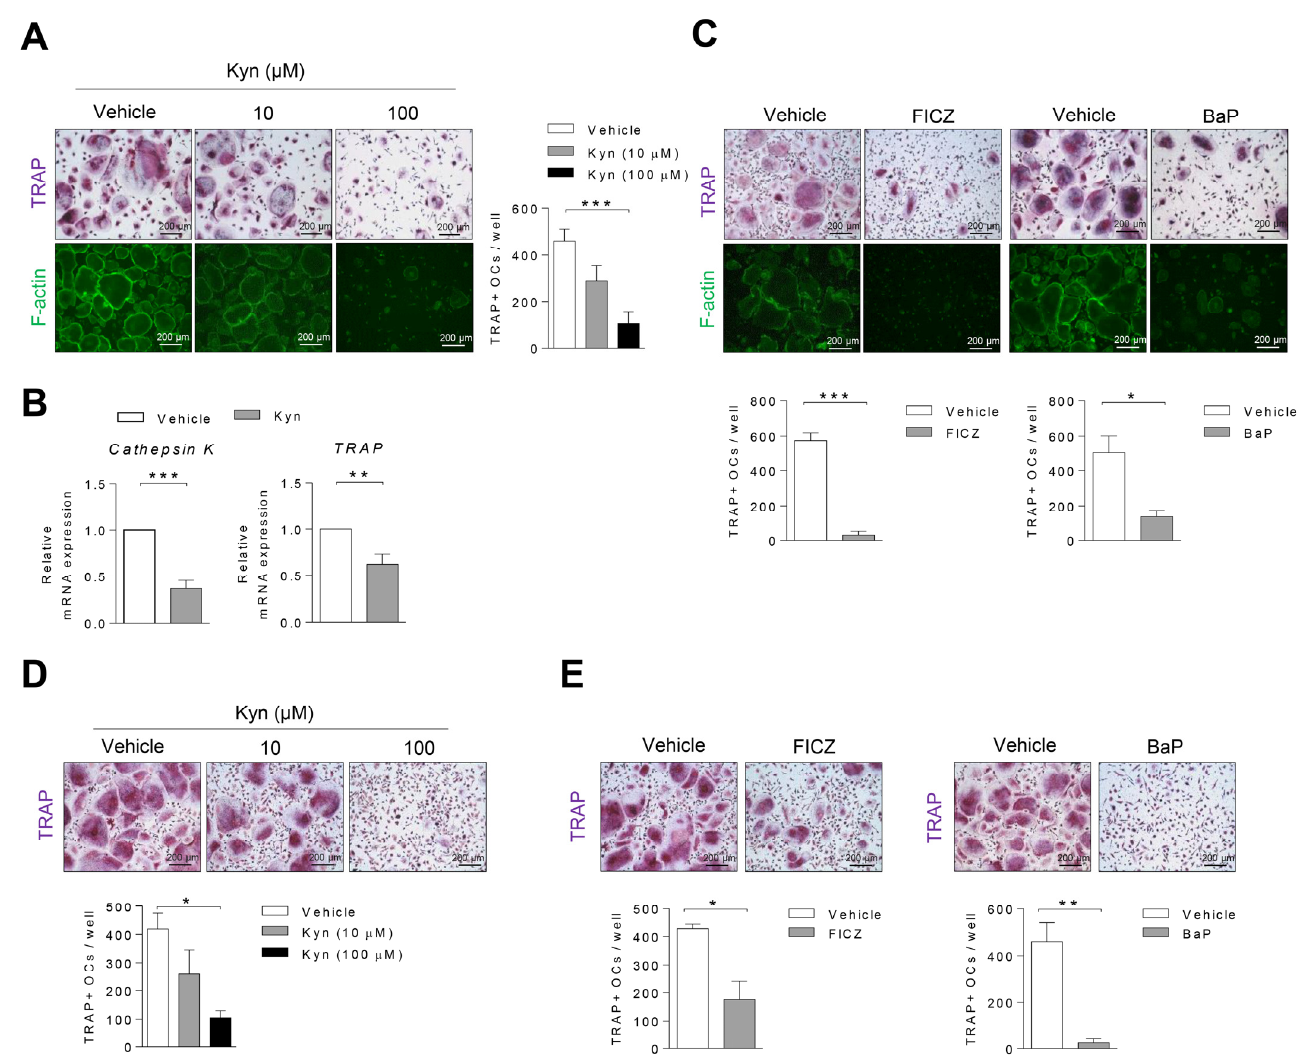
Figure 2. AhR agonists treatment inhibits osteoclast differentiation. Human PBMC CD14+ cells were cultured with ( A ) Kyn (0, 10, 100 µ M), ( C ) FICZ (0, 30 nM), or BaP (0, 100 nM) for 8 days under osteoclast differentiation conditions. The cells were stained with TRAP and F-actin ring on day 8, and the TRAP+ osteoclasts were counted. ( B ) Mature osteoclast markers of Cathepsin K and TRAP mRNA expression were measured using RT-qPCR and normalized to that of GAPDH . ( D , E ) Human RA SFMC CD14+ cells were cultured with ( D ) Kyn, ( E ) FICZ, or BaP for 9 days under osteoclast differentiation conditions. On day 9, the cells were stained with TRAP, and the TRAP+ osteoclasts were counted. Images were taken at original magnification 100 X. Scale bar is 200 µ m. Data are shown as mean ± SD of more than three independent experiments and a one-way ANOVA test or unpaired t -test were applied. * p < 0.05, ** p < 0.01, *** p < 0.001.